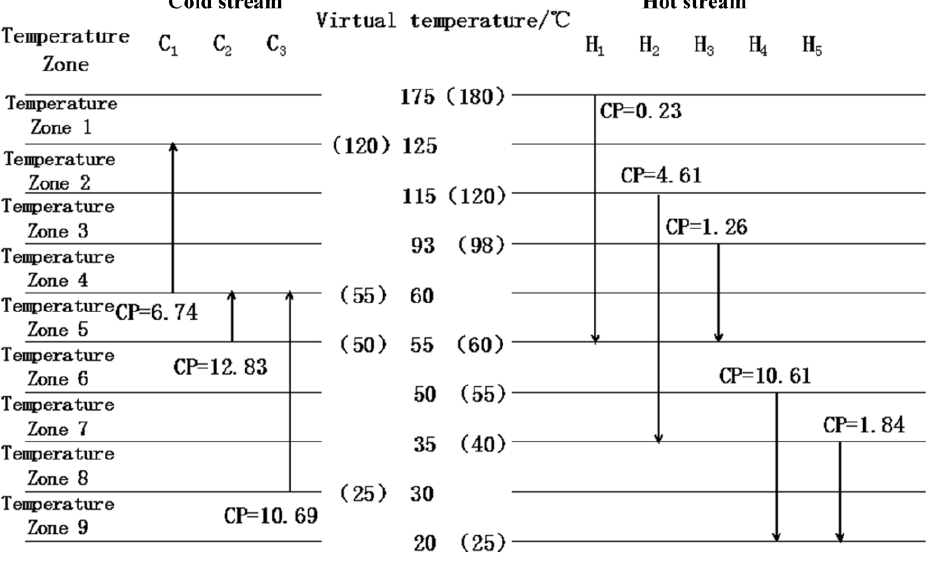
Figure 4. Temperature zone division.